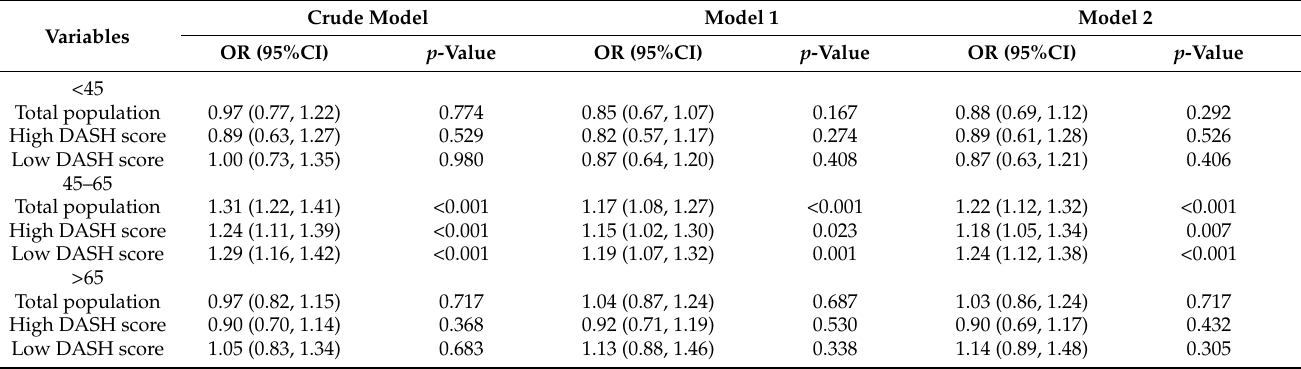
Table 2. Associations between menarche age and hypertension by age at